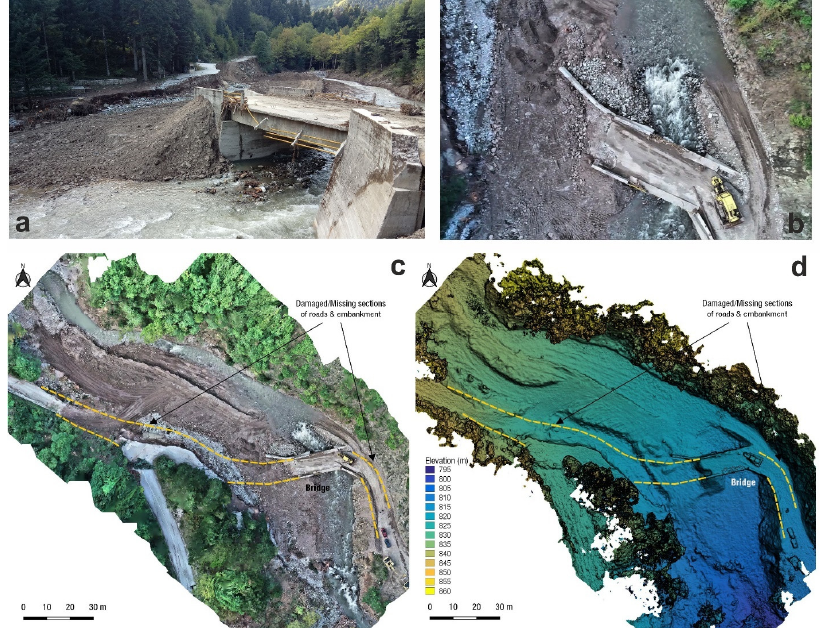
Figure 9. Damaged bridge crossing of Karitsiotis River near Belokomiti. Ground ( a ) and vertical aerial ( b ) images of the damaged bridge undergoing repairs on 1 October 2020. UAS orthophoto ( c ) and digital surface model ( d ) of the Karitsiotis River bridge area (surveys 1 October 2020).